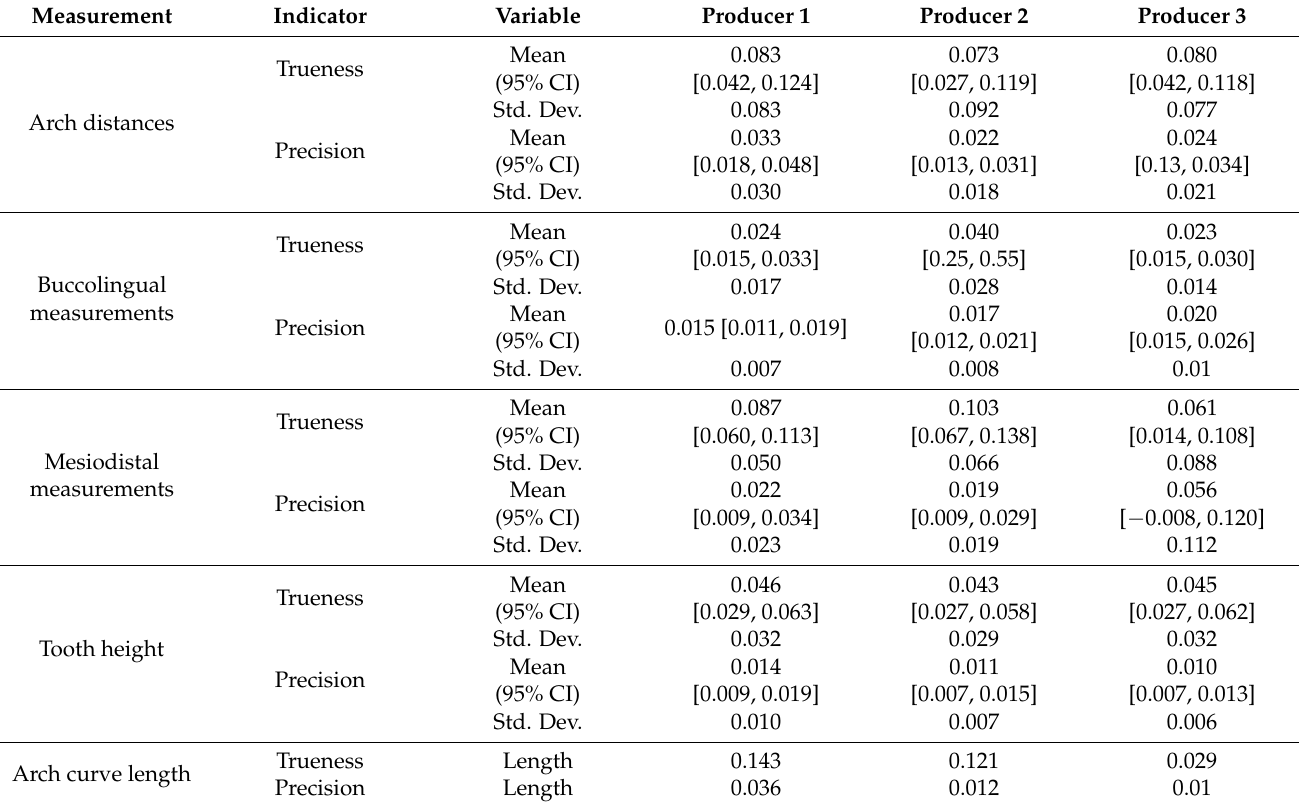
Table 1. Descriptive statistics for precision and trueness for the three materials for each type of